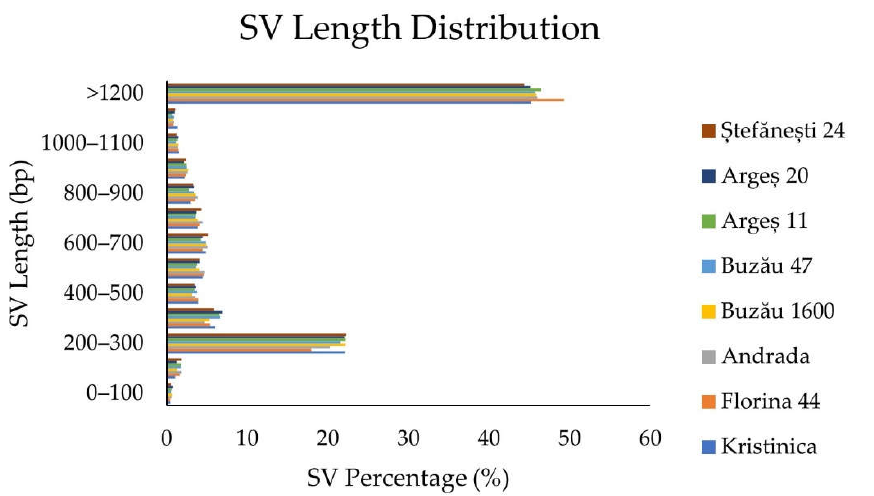
Figure 6. Structural variations’ (SVs) length